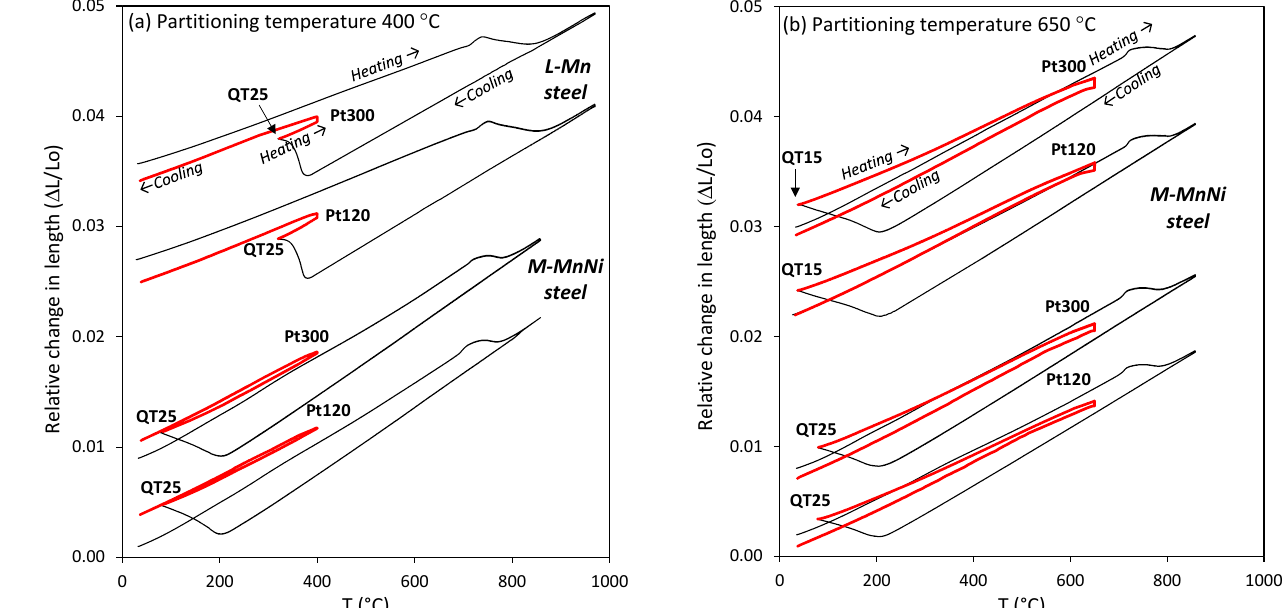
Figure 4. Dilatometry curves of the applied Q&P cycles: ( a ) partitioning temperature (PT) of 400 °C in L-Mn and M-MnNi steels, with QT25 condition; ( b ) partitioning temperature of 650 °C in M-MnNi steel, with QT25 and QT15 conditions. The curves corresponding to 120 s and 300 s partition times (Pt120 and Pt300, respectively) are shown in each condition.